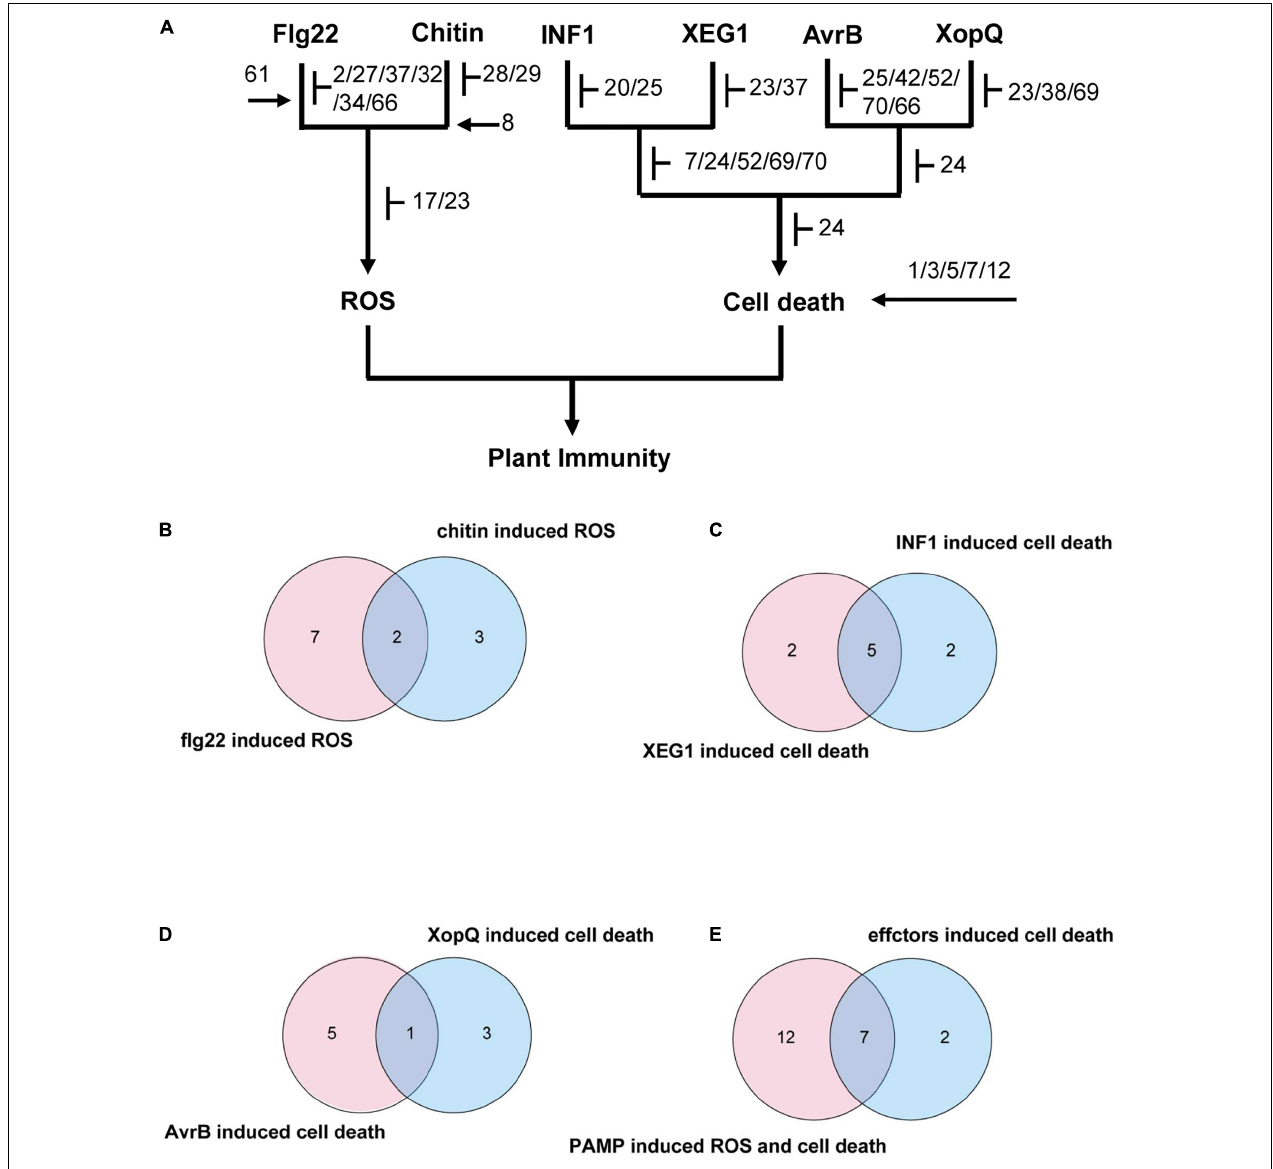
FIGURE 6 | Summary the roles of GmMRLKs in different plant immune responses. (A) Classification of GmMRLKs based on their effects on different immune responses. T bar indicates suppression of immunity and arrows indicates promotion of immunity. In the chart, GmMRLKs that can be connected to certain immune response indicating that they play a role in this immune response. (B) Venn diagram showing the number of GmMRLKs that function in flg22- and chitin-induced ROS production. (C) Venn diagram showing the number of GmMRLKs that function in XEG1- and INF1-induced cell death. (D) Venn diagram showing the number